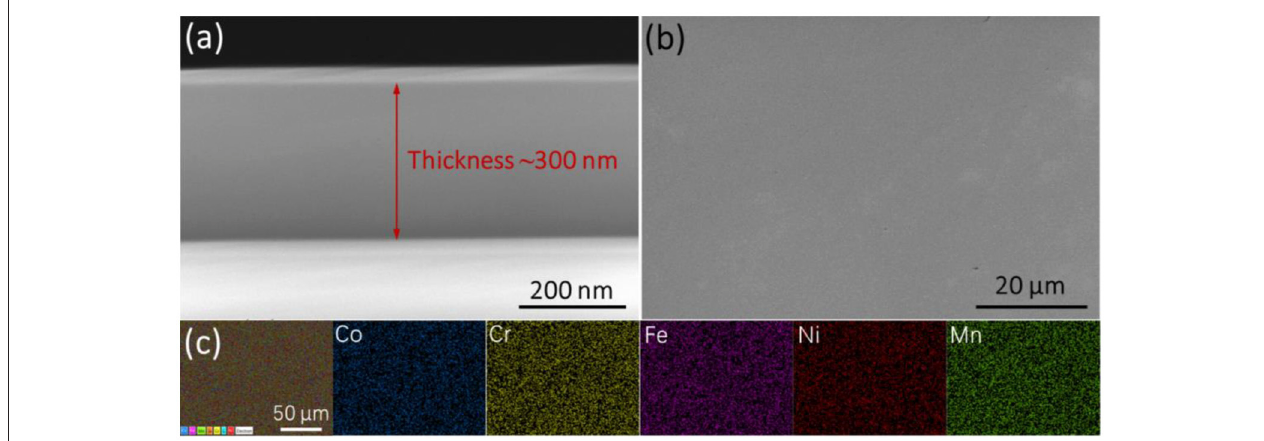
FIGURE 2 | Cross-sectional (a) , plan-view (b) SEM images, and SEM-EDS mapping (c) images of the CoCrFeNiMn high-entropy thin film, indicating the homogeneous element distribution.